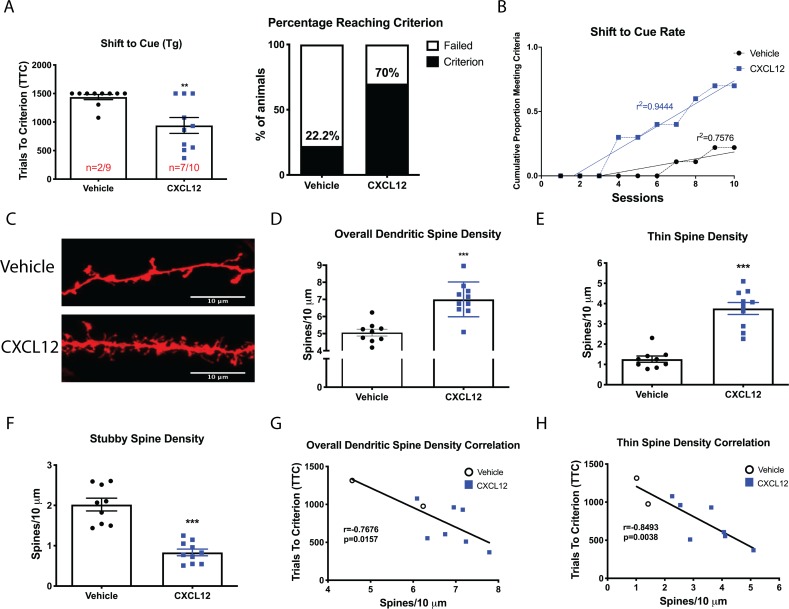
Once daily CXCL12 treatment significantly enhanced set-shifting abilities of HIV-Tg rats and completely restored dendritic spine density and morphology in the mPFC.(A) A greater percentage of CXCL12-treated rats reached criterion on the shift to cue phase and also took significantly fewer trials to complete the task. N = 9 animals/vehicle and 10 animals/CXCL12, p=0.03. (B) The rates at which the groups reached criterion were significantly different, with CXCL12-treated animals learning at a faster rate. N = 9 animals/vehicle and 10 animals/CXCL12, F(1,16)=44.3781, p<0.001. (C) Representative image of DiOlistically labeled mPFC slices from HIV-Tg rats treated with either vehicle or CXCL12. (D) Adult male HIV-Tg rats treated with CXCL12 had significantly higher overall dendritic spine density in layer II/III pyramidal neurons of the mPFC. N = 9 animals/vehicle and 10 animals/CXCL12, 8 dendrites measured for each animal and averaged into single data point, ***p<0.001 (E) Further analysis on spine morphology revealed a specific increase in the number of thin spines. N = 9 animals/vehicle and 10 animals/CXCL12; ***p<0.001. (F) CXCL12 treatment resulted in a significant reduction in stubby spine density in HIV-Tg rats. N = 9 animals/vehicle and 10 animals/CXCL12; ***p<0.001 (G) As previously observed, overall dendritic spine density was significantly negatively associated with trials to criterion on the set-shifting phase. N = 19 animals, Pearson’s r = −0.7676, p=0.0157. (H) This relationship became even stronger when only thin spines were correlated with the number of trials required to complete the task. N = 19 animals, Pearson’s r = −0.8493, p=0.0038.Figure 3—source data 1.WT and HIV-Tg ±CXCL12 raw data and statistical analysis.